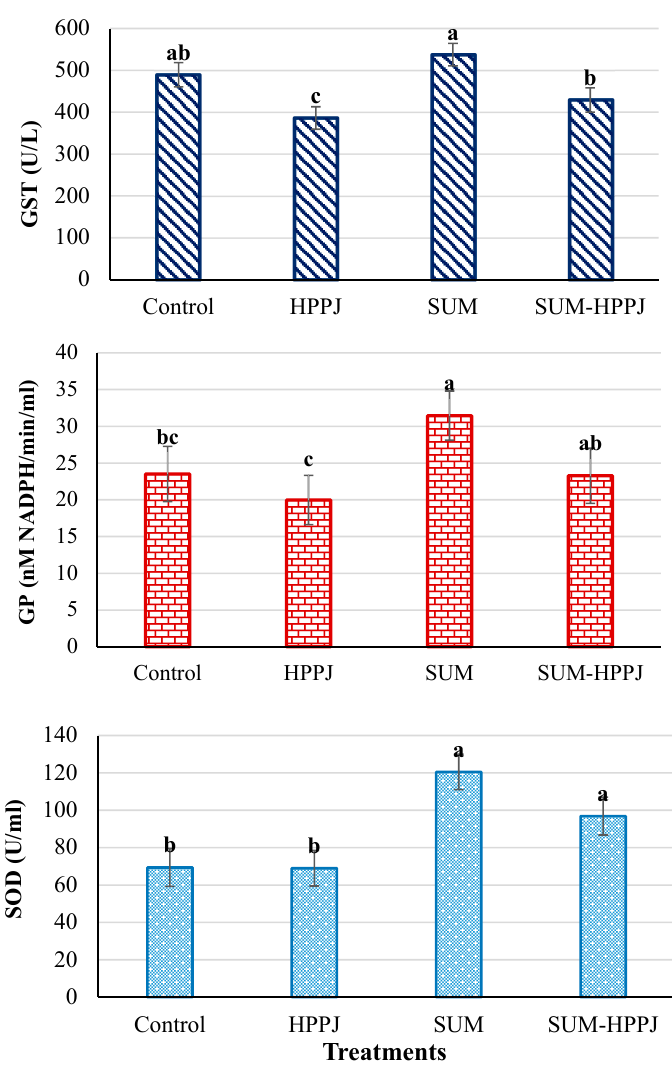
Figure 1. Mean activities of oxidative stress enzymes ± SE: GST; glutathione-S-transferase (U/L), GP; glutathione peroxidase (nM NADPH/min/mL), and SOD; superoxide dismutase (U/mL) of white albino rats who were orally given corn oil (Control), sumithion (SUM; 85 mg/kg, 1/20 LD 50 ), HPPJ (a mixture of citrus bee honey, propolis, palm pollen grains, and royal jelly), and SUM-HPPJ for 28 consecutive days. Columns labeled with the same small letter were not significantly different based on Tukey’s post hoc specific comparison ( P < 0.05).